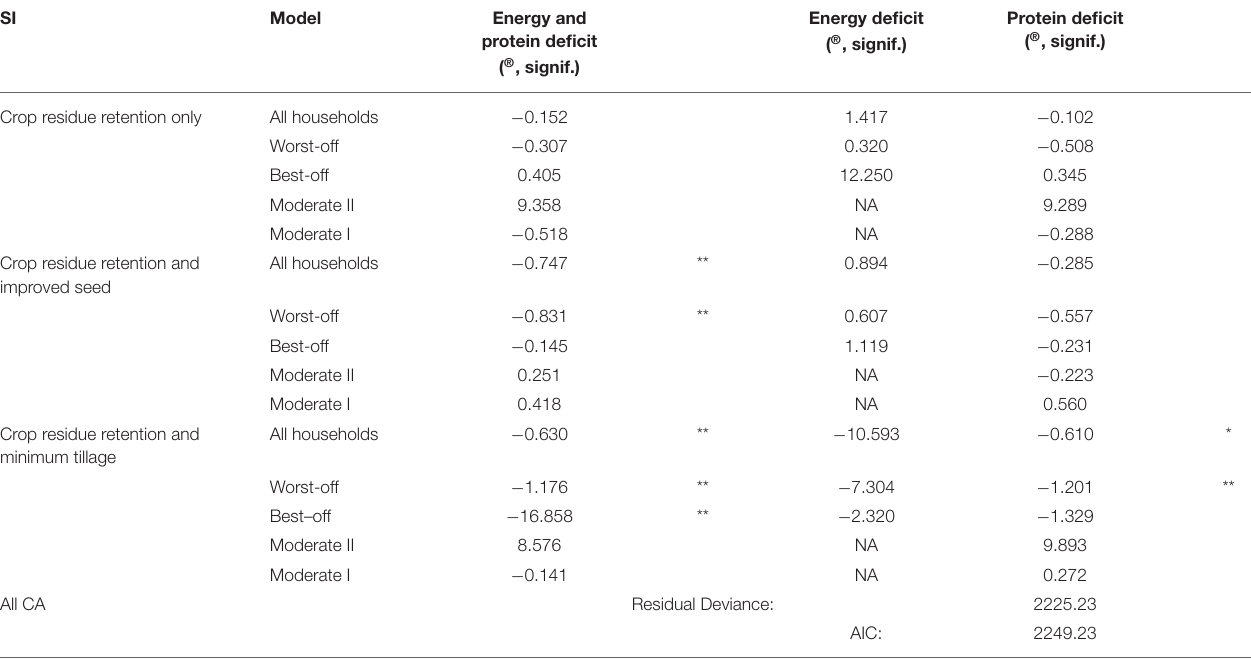
Energy deficit Protein deficit ( ® , signif.) ( ® , signif.)